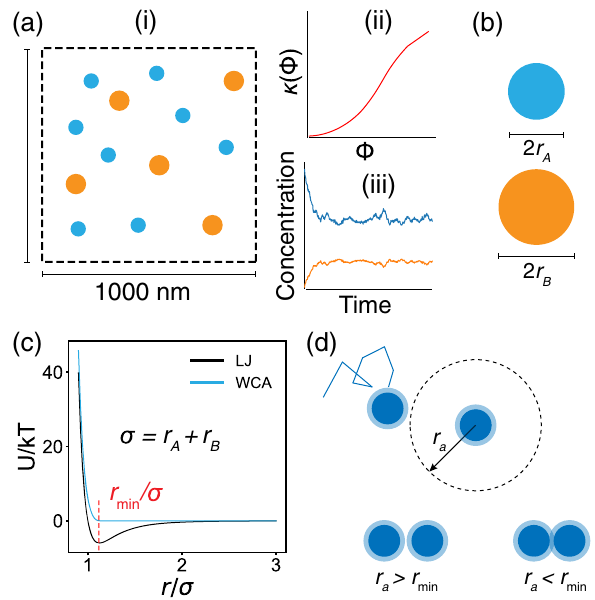
FIG. 1. Hierarchical multiscale simulation framework: (A) We combine molecular simulation with the chemical kinetic model to study association reaction kinetics at broad spatiotemporal scales. (i) Using BD-GFRD, we study how short-ranged pairwise interaction modifies the rate of association reaction between two molecules on a 2D periodic box of size 1 × 1 μ m 2 . (ii) The measured rate κ is concentration dependent, and its dependence on concentration is represented by the function κ ð Φ Þ , where Φ is the product of the concentrations of the reactants, aka the mass action. (iii) κ ð Φ Þ is used in a spatially homogeneous chemical kinetic model to study concentration variations at timescales not reachable through molecular simulations ( > 1 s). (B) The mol- ecules are represented as disks of radius r and r , and (c) they A B interact through either Lennard-Jones (LJ) or Weeks-Chandler- Andersen (WCA) interaction. (D) The molecules react as soon as < r they are closer than the reaction radius r . If r [see (C) a a min and (D) for definition of r ], there is a strong excluded volume min interaction between the reactant molecules. The light blue region surrounding a molecule denotes the region over which excluded volume interaction is felt by another molecule. More precisely, when two light blue regions touch, the distance between the two molecules is r min